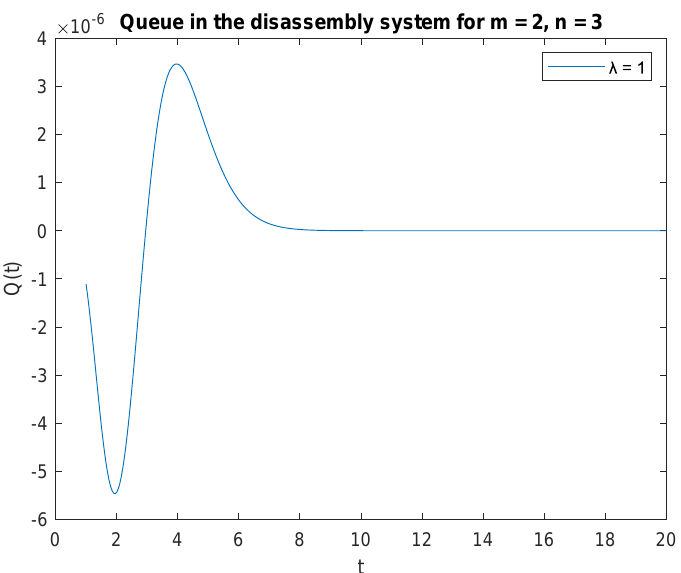
Figure 7. Impact of buffer capacity on probability P { X ( t ) = 2 | X ( 0 ) = 3 }